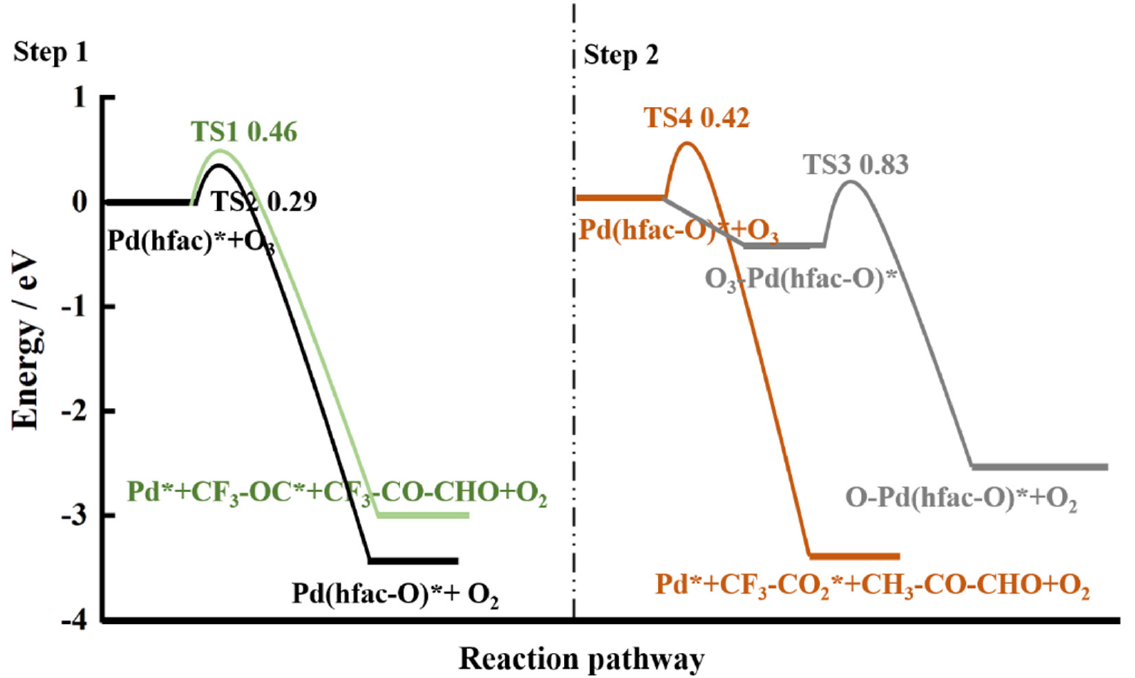
Figure 3. Energy profile of the reaction of ozone with ( a ) Pd(hfac)* (step 1) or ( b ) Pd(hfac-O)* (step 2) on clean Si (100) surface.